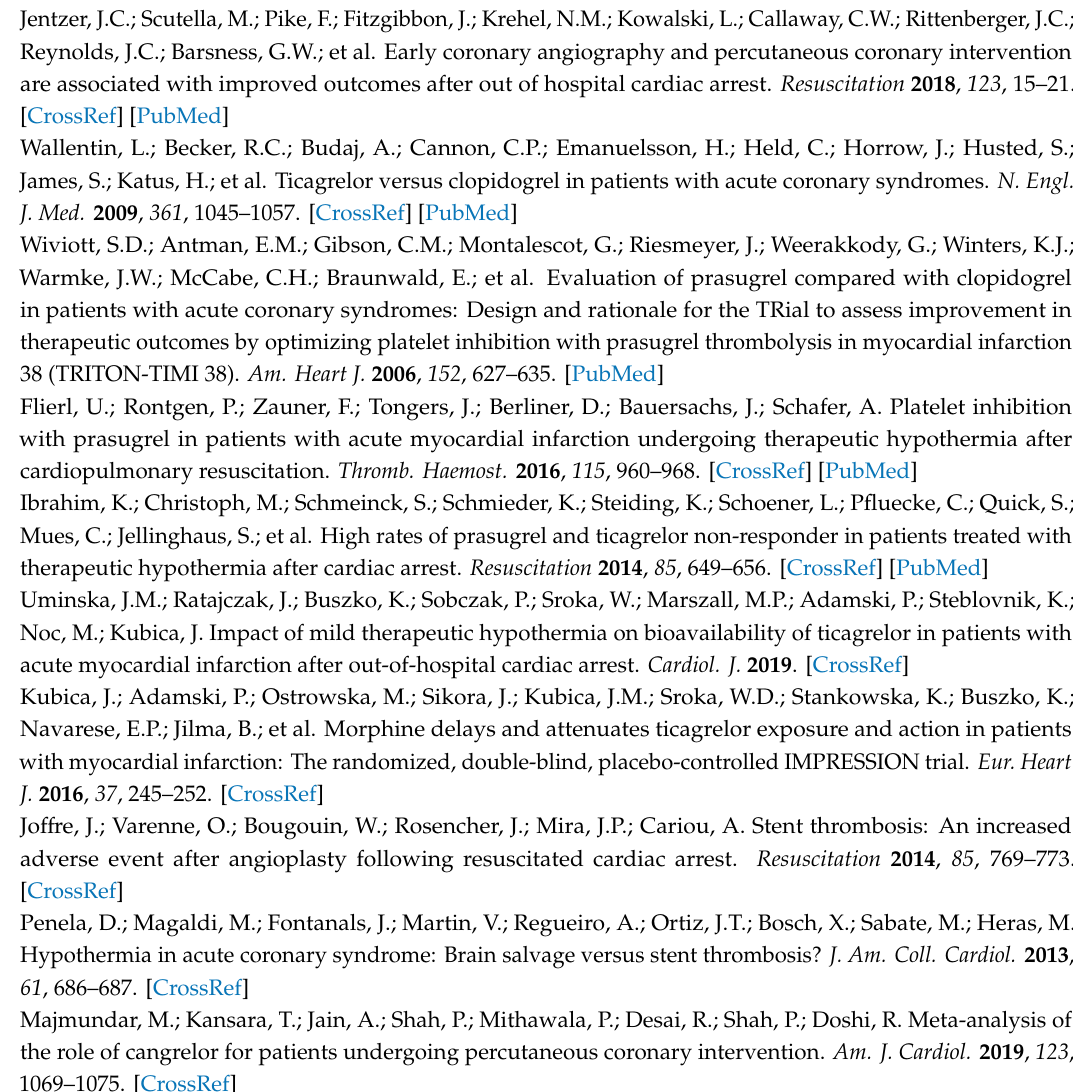
Table S1: Results of multivariable Poisson